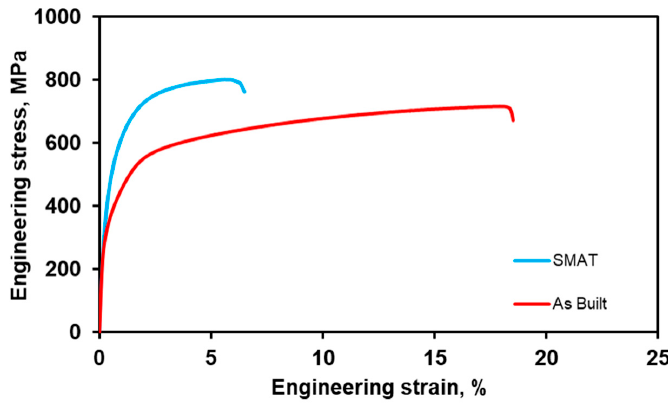
Figure 8. Representative tensile stress–strain curves of as-built and SMAT processed SS 316L speci- mens.